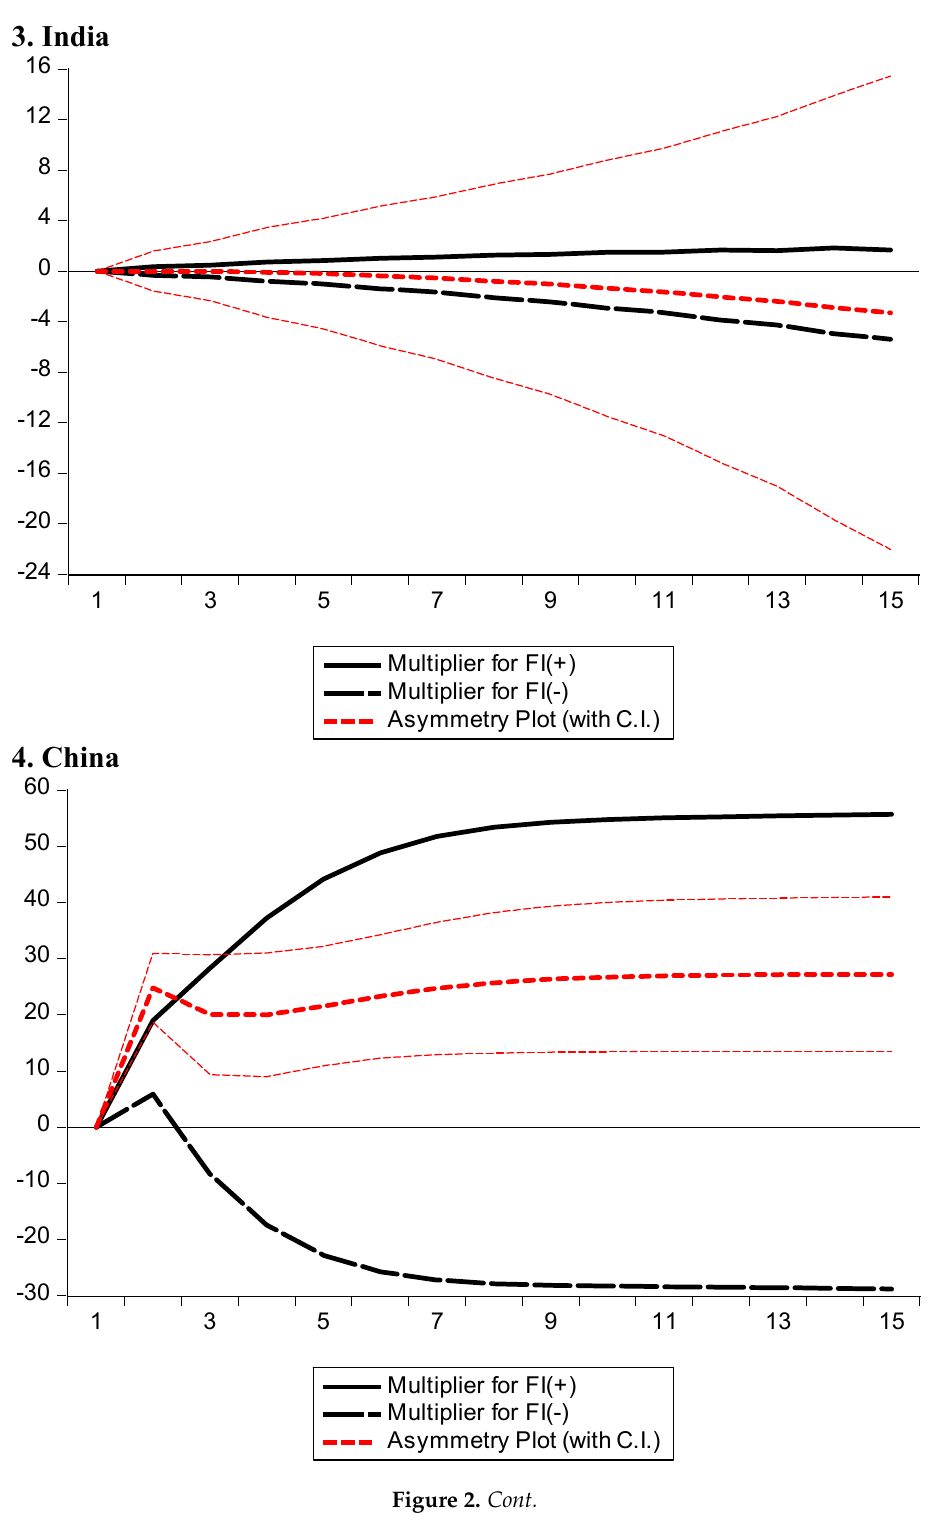
Multiplier for FI(+) Multiplier for FI(-) Asymmetry Plot (with C.I.) Figure 2.